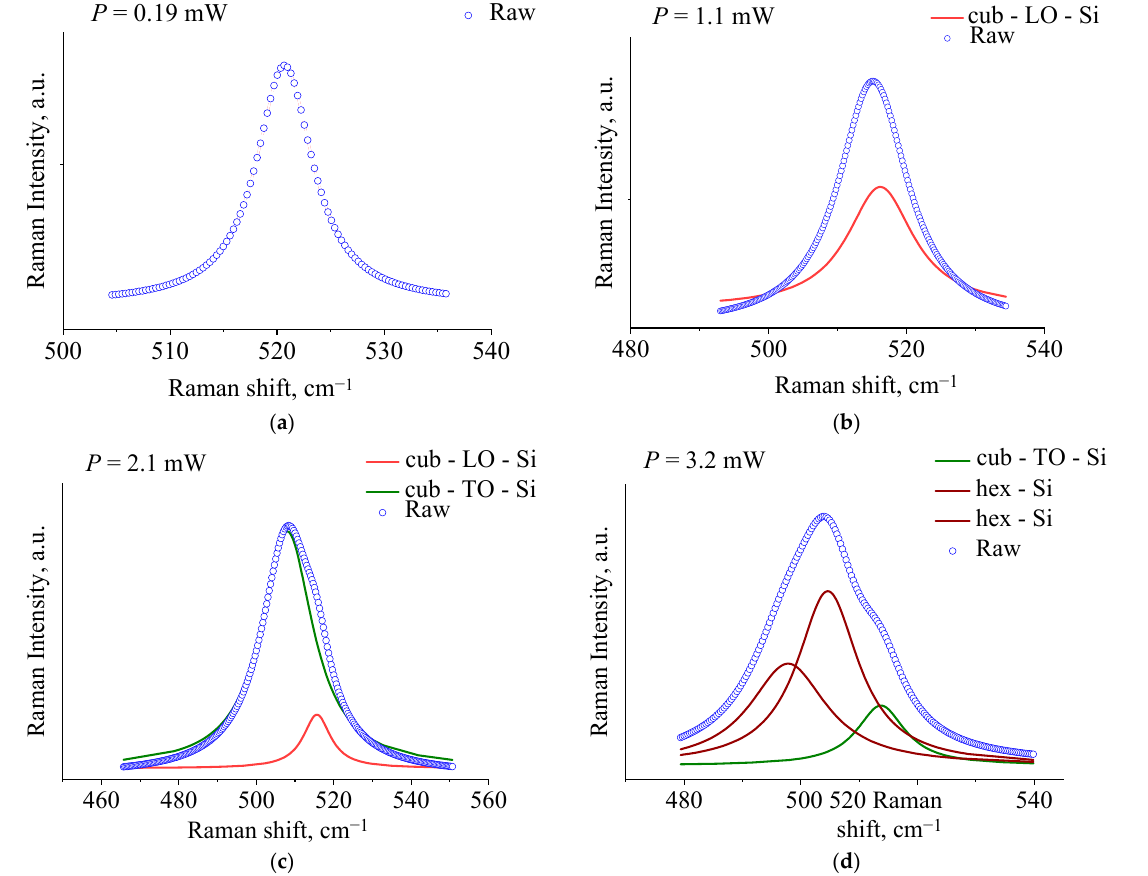
Figure 3. Deconvoluted Raman spectra of the films formed by Si NPs with average size of 100 nm demonstrating a photo-induced transition of phase from cubic ( a – c ) to hexagonal one ( d ).